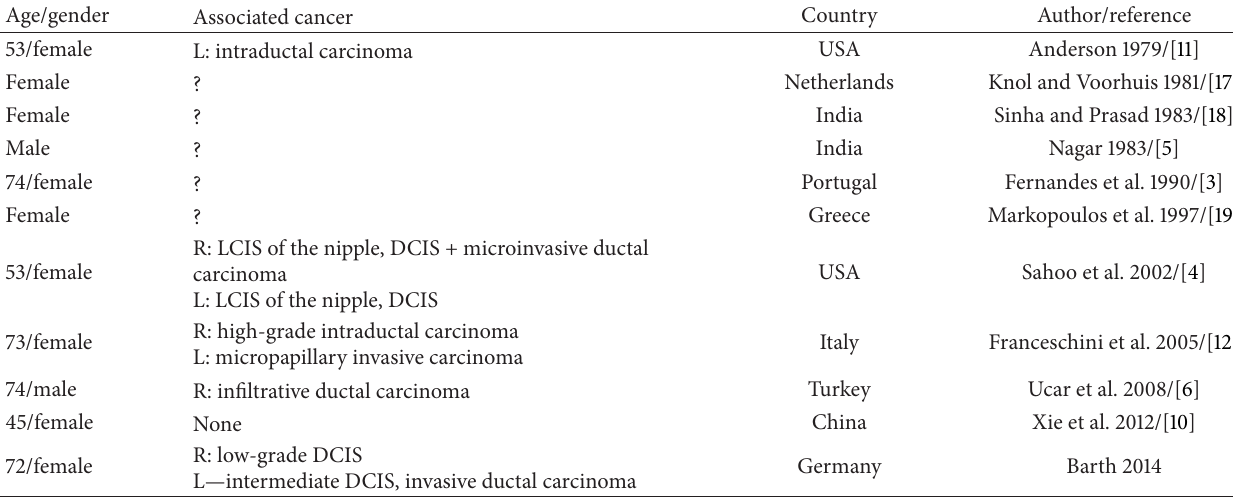
Table 1: Summary of all available cases of bilateral Paget’s